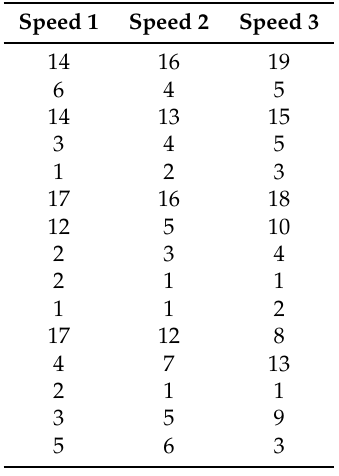
Table A3. Energy consumption of operations of the small